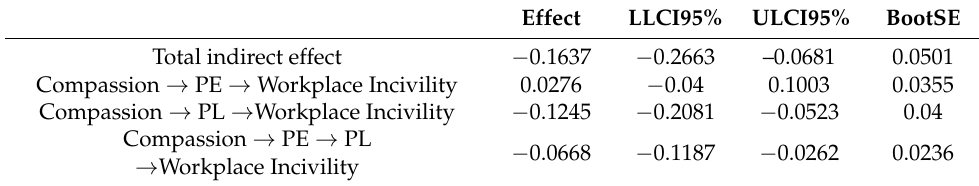
Table 3. Indirect effects for the double